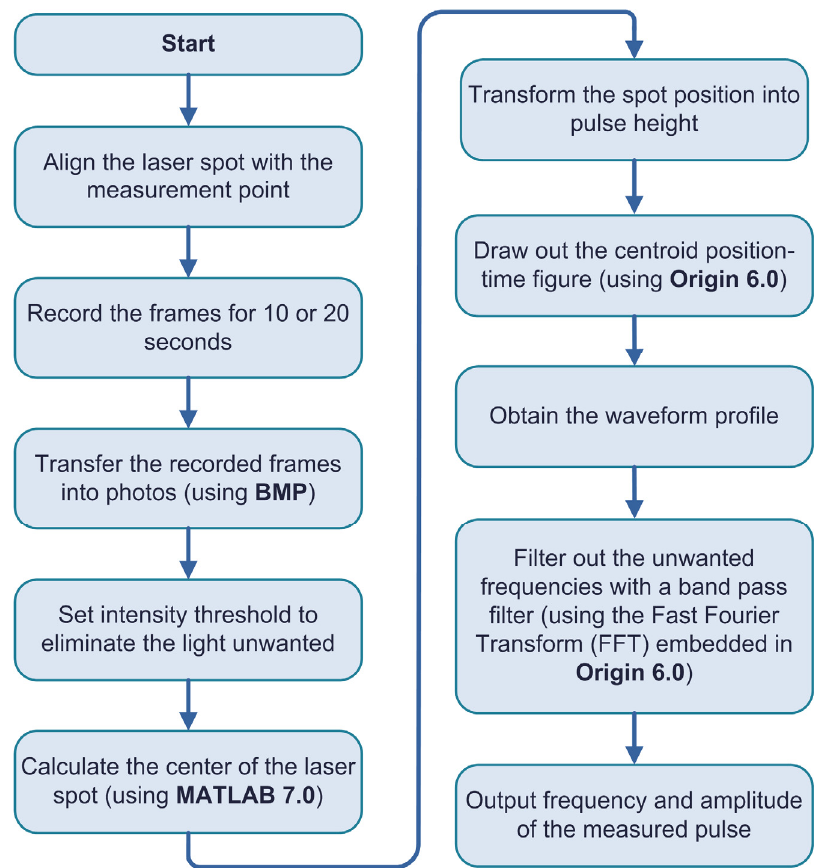
Figure 4. Signal processing flowchart for the proposed arterial pulse measurement system. spectrum analysis. Fifteen frames per second were captured by the CMOS image sensor. The